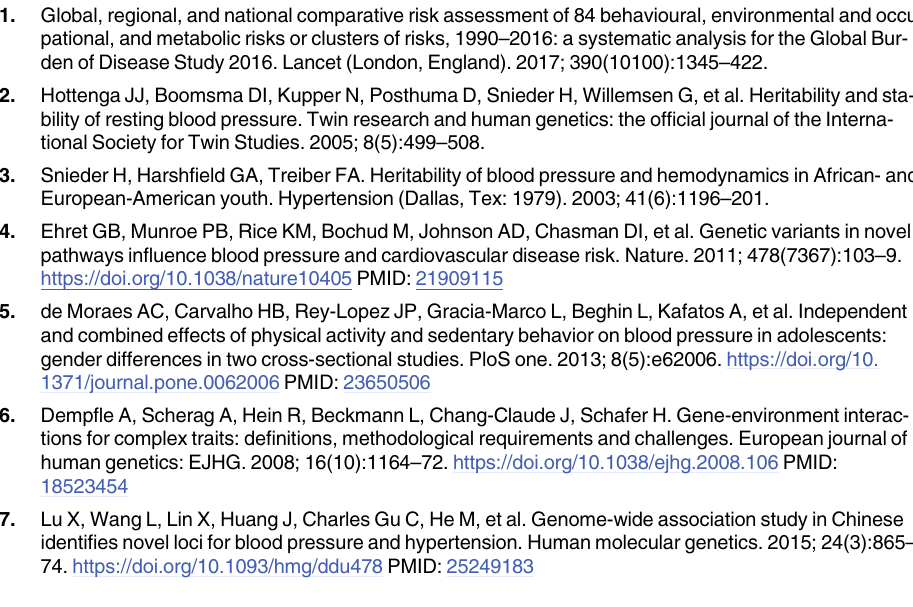
S4 Table. Interaction between lifestyle behaviors and the CACNA1D rs9810888 polymor- phism on